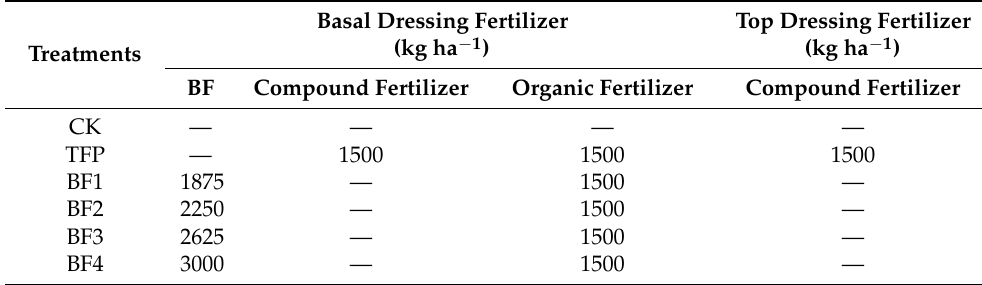
Table 1. Fertilizer amounts of different treatments.